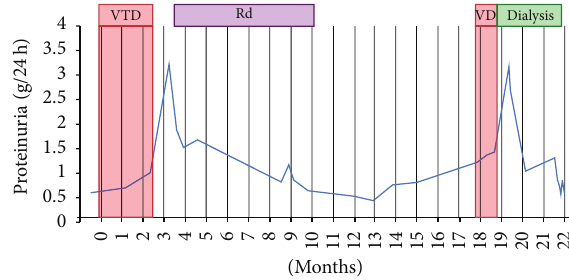
Figure 5: Second episode of AKI. 𝑥 -axis: time (weeks); 0 = start of bortezomib rechallenge (18 months after first dose); 𝑦 - axis: plasma creatinine (mg/dL). VD: bortezomib-dexamethasone; arrows: bortezomib